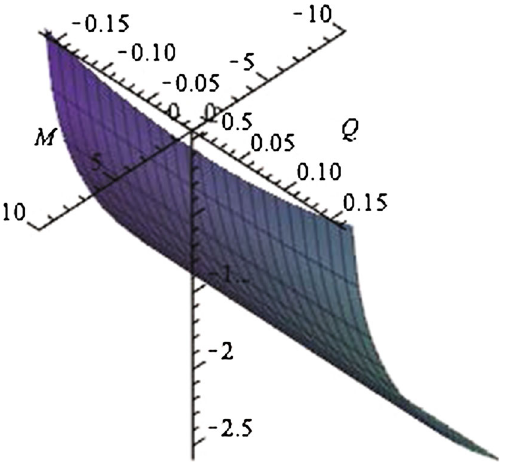
Fig. 10 Location of the roots ξ 3 for the RN black hole as functions of Q , M . We show that ξ 3 is the largest root